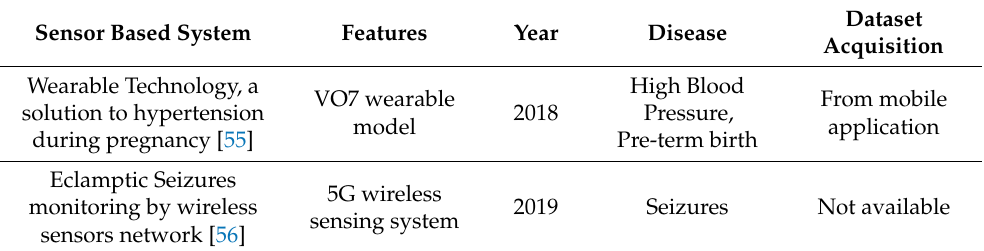
Table 2. Sensors used in maternal healthcare